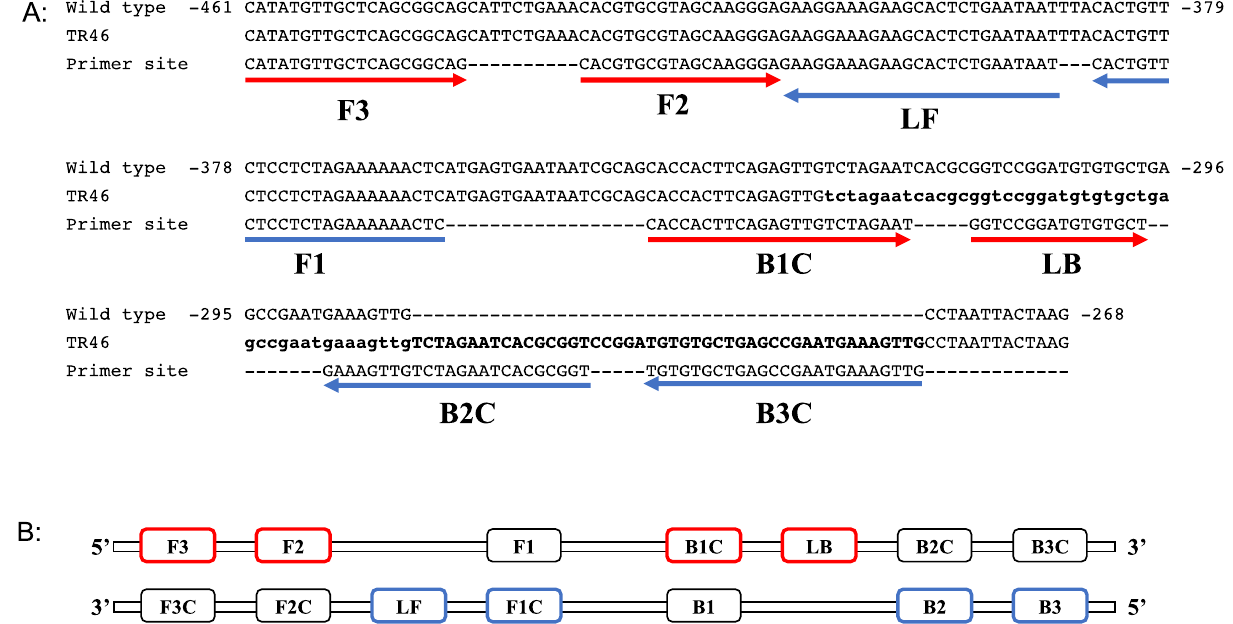
Figure 1. Genetic information for the design of the LAMP primer sets. ( A ) Schematic illustration of cyp51A gene showing LAMP primer positions and corresponding sequences of TR46 bp promoter tandem repeat compared to wild-type sequences. ( B ) Primers F3, F2, F1, B1, B2, and B3 show primer sequence positions. Sequences of some primers are complementary, as shown in Table 2. See LAMP primer and methods, which are shown in Refs. 19,20 .